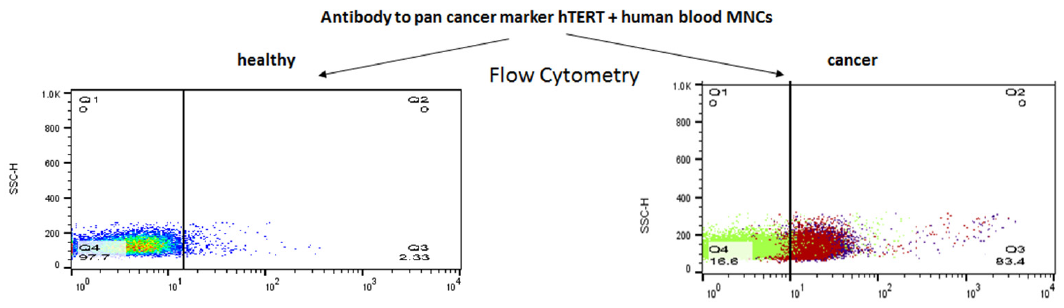
Figure 7. A summary of our α -hTERT mAb specificity to cancer cells .